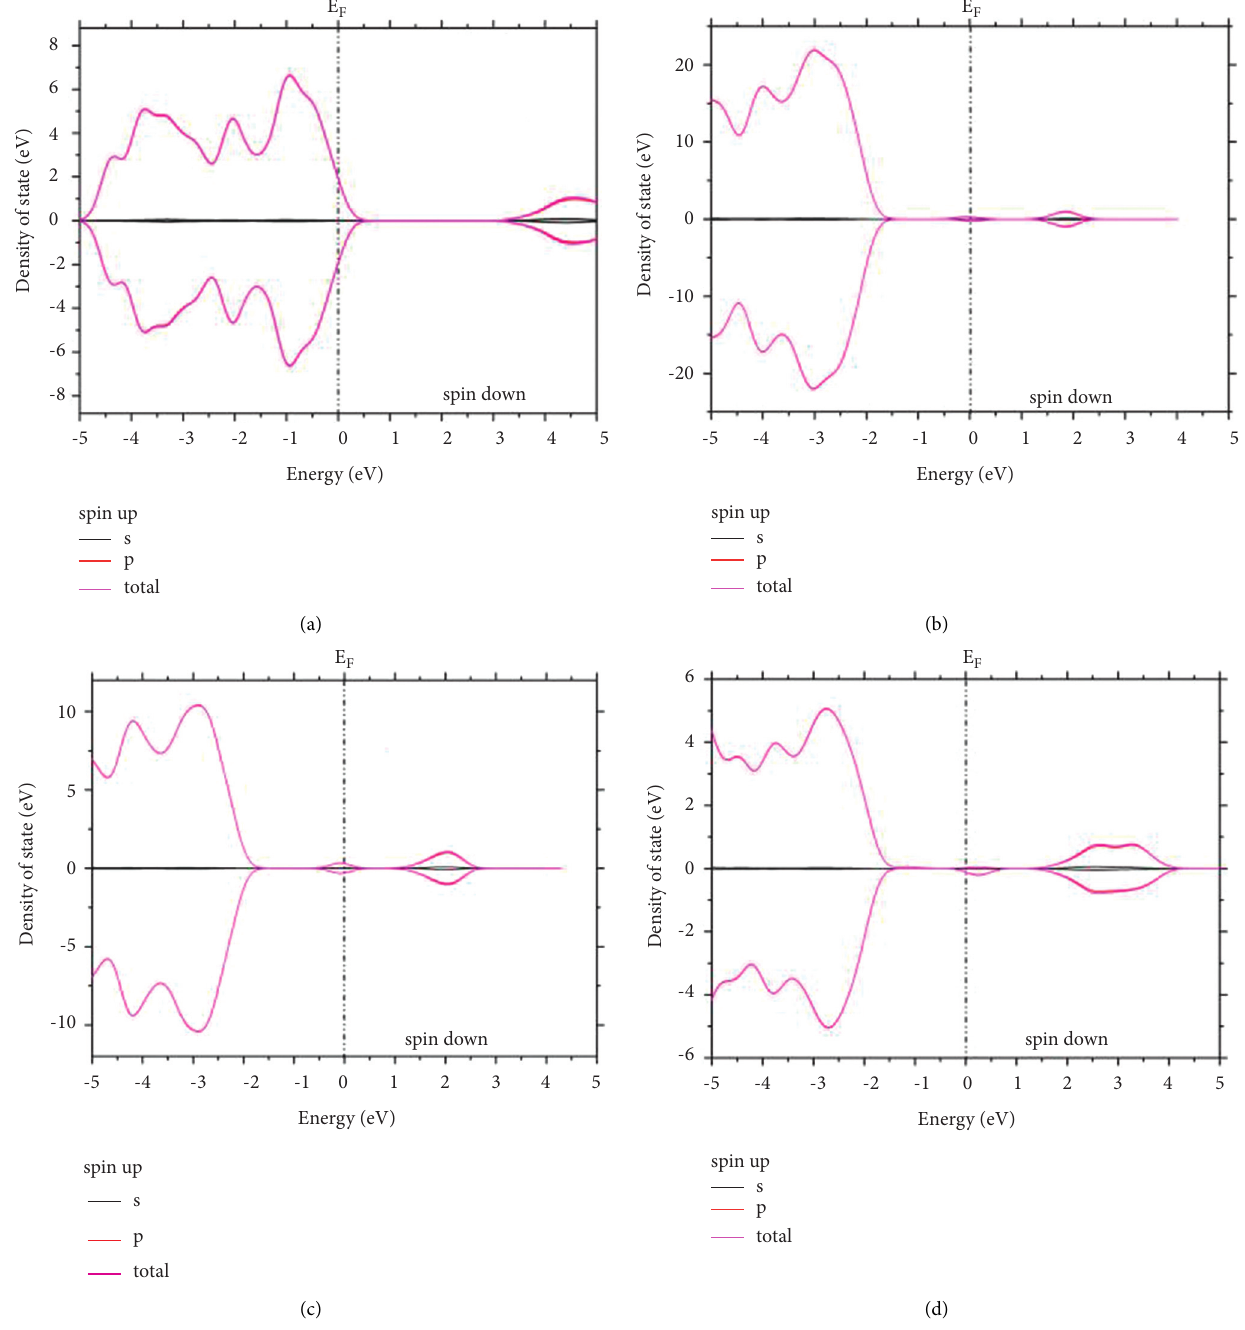
Figure 14: Spin density of states near the Fermi level of O for anatase TiO 12.5%